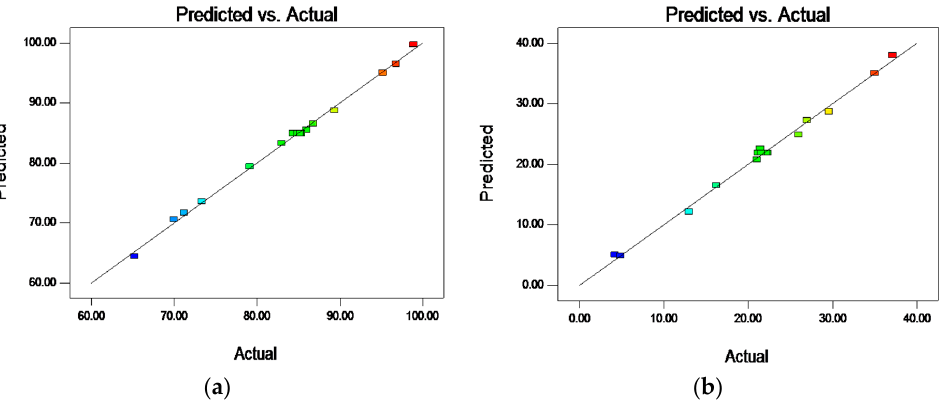
Figure 4. Design expert plot of ( a ) chalcopyrite and ( b ) molybdenite: Actual values versus predicted response by Box–Behnken design (BBD).